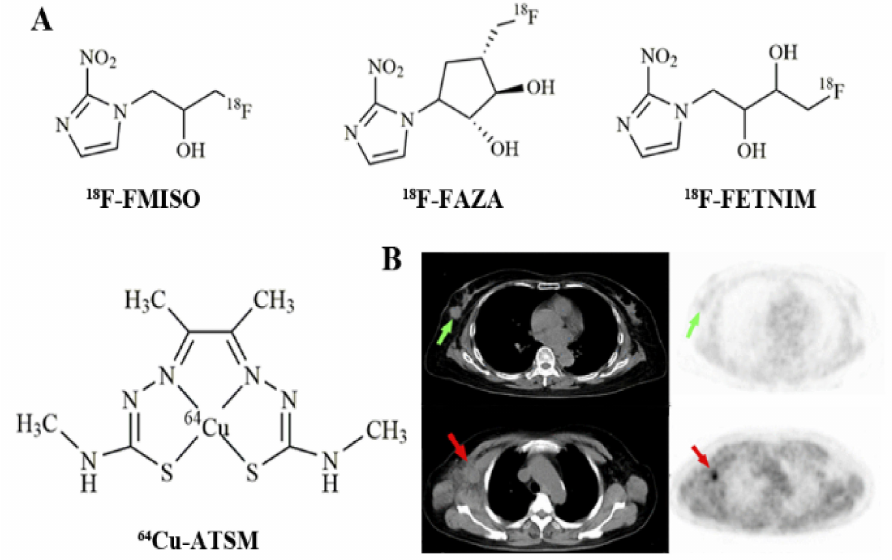
Figure 4. Chemical structure of ( A ) 18 F-FMISO, 18 F-FAZA, 18 F-FETNIM, and 64 Cu-ATSM; ( B ) 18 F- FMISO PET imaging of a patient with right breast tumor in situ (green arrow), CT and PET images, and a patient with right axillary node metastasis (red arrow), CT and PET images